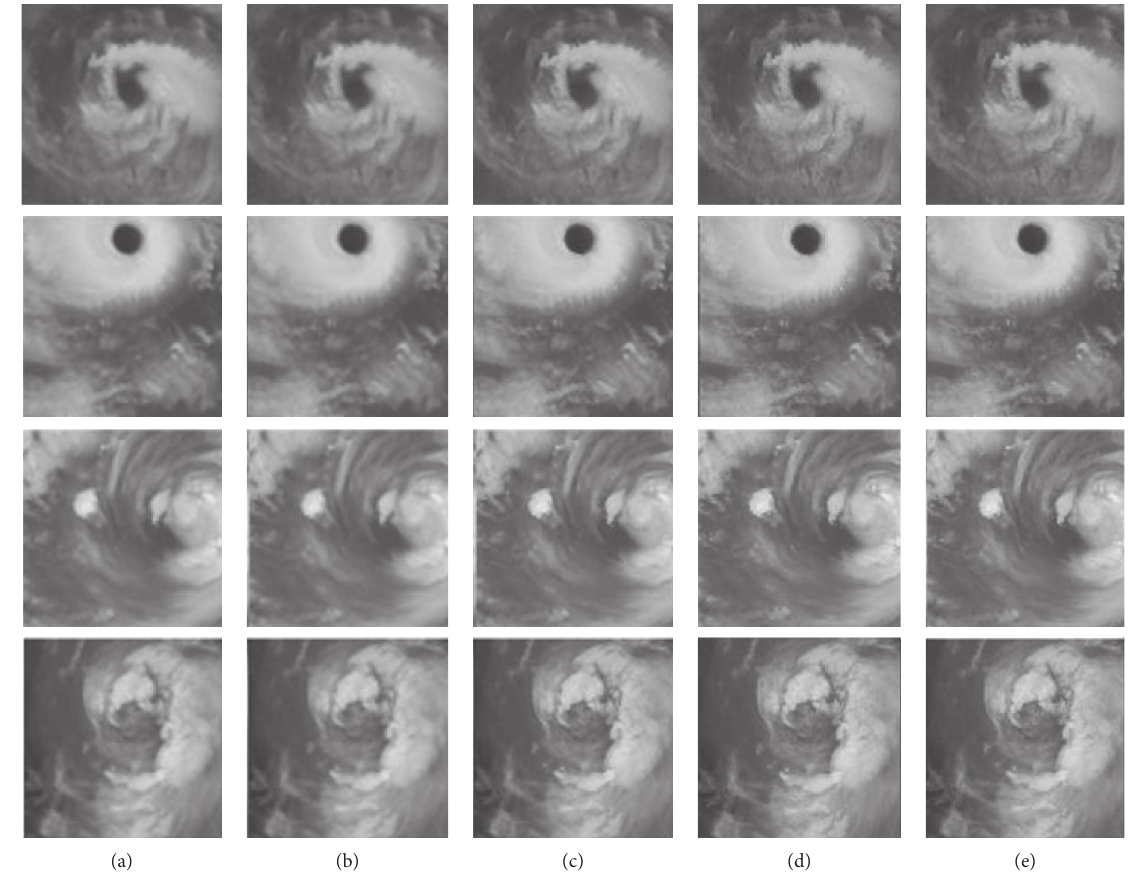
Figure 4: Comparison of superresolution results for infrared images (4 × ). (a) Degraded image. (b) Bicubic. (c) ZSSR. (d) MSLp. (e) Real image.